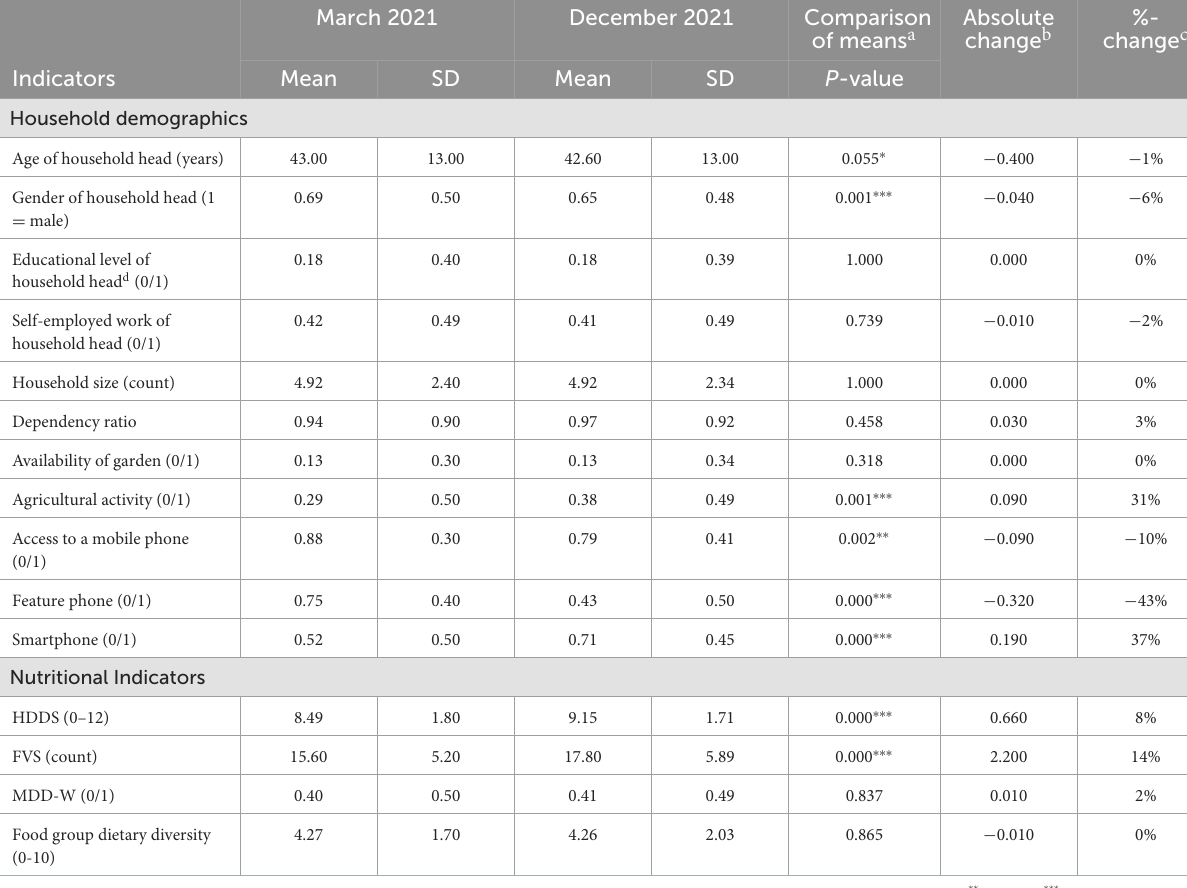
TABLE 2 Socioeconomic data in the March and December